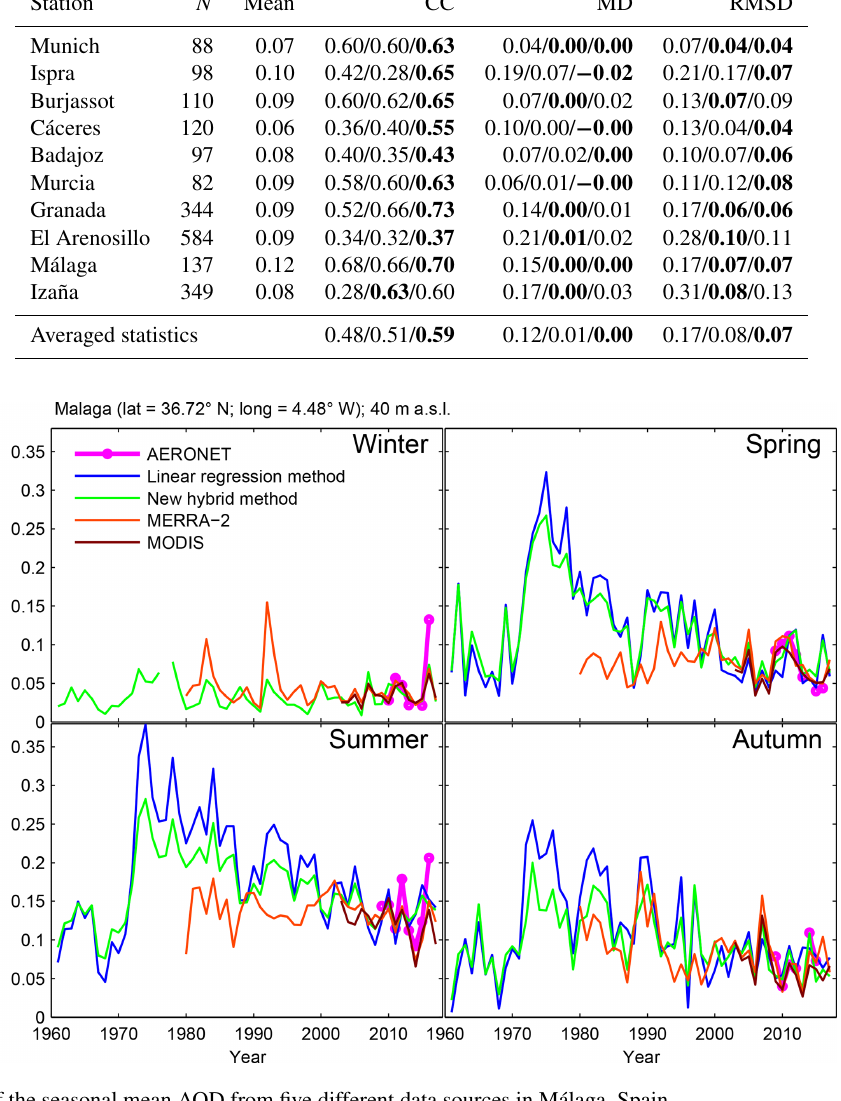
Figure 8. Time series of the seasonal mean AOD from five different data sources in Málaga,